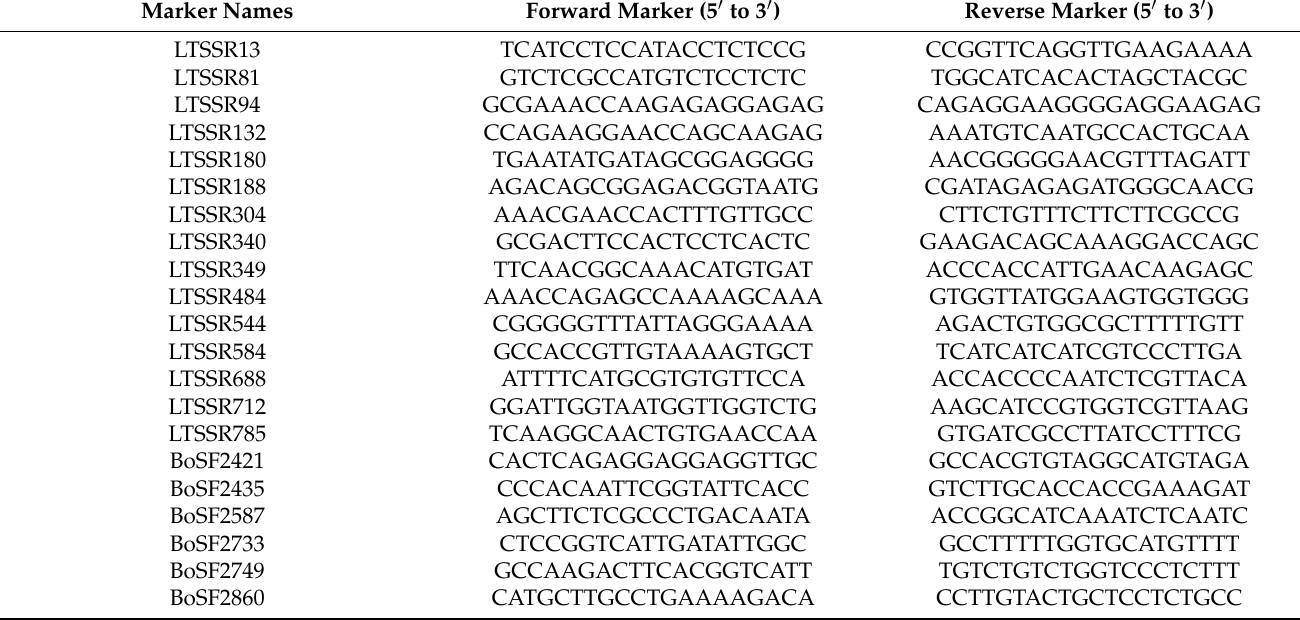
Table 2. Sequences of SSR markers used in this